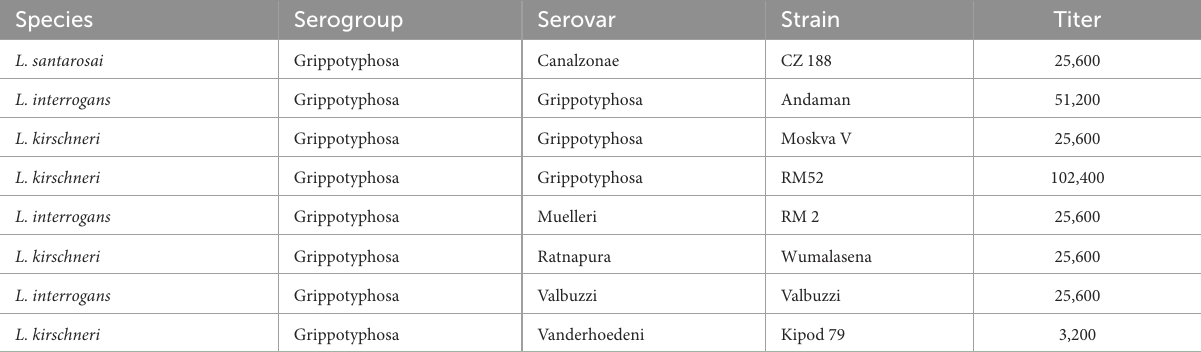
TABLE 1 MAT titers of the red panda isolate when tested with reference antisera against serovars within the serogroup Grippotyphosa. Species Serogroup Serovar Strain